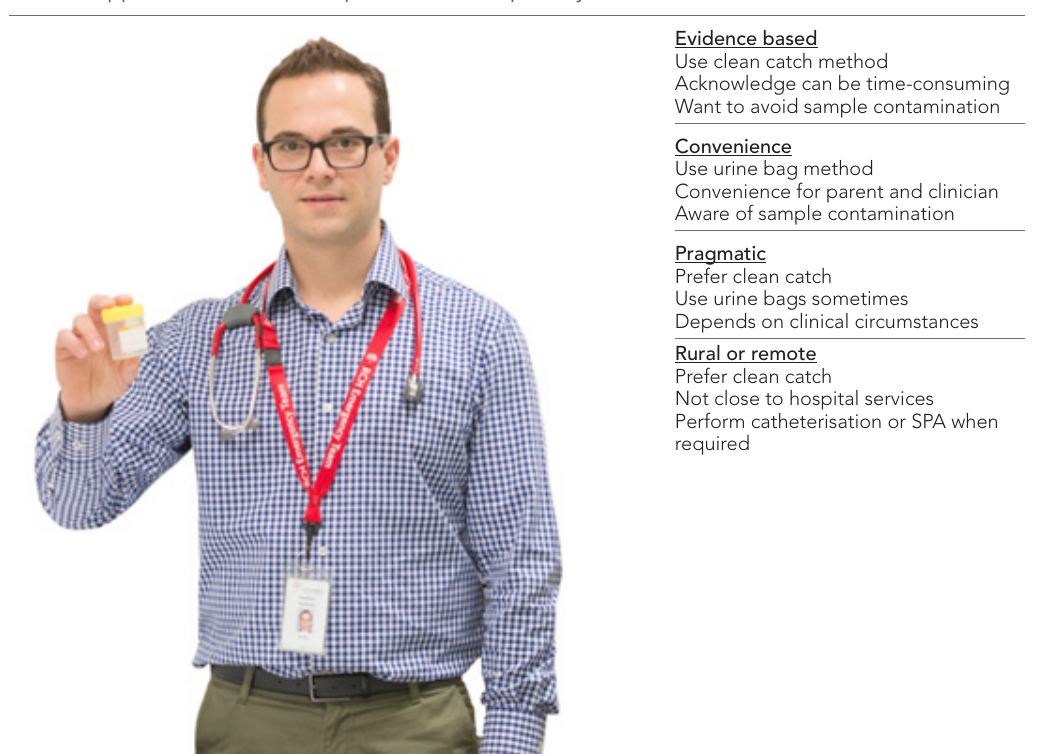
Table 2 Approaches to urine sample collection in primary